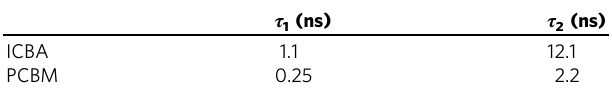
Table 2 Decay time of PEA15-SCN fi lm with ICBA and